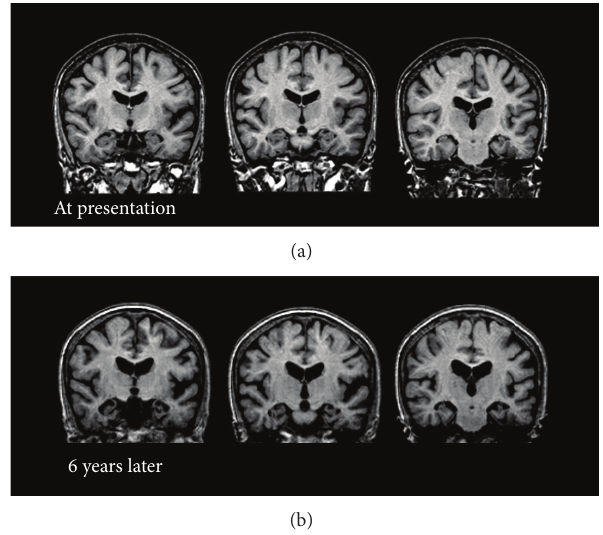
Figure 8: Coronal T1 weighted brain Magnetic Resonance Image (MRI) of the patient in Case C at presentation (a) and 6 years later (b). No remarkable vascular changes or mass signs were observed. Diffuse cerebral and hippocampal atrophy, as well as enlargement of the lateral ventricles, which advanced in 6 years, was consistent with comorbid Alzheimer’s disease. 3D-SSP analysis: decrease RT.LAT